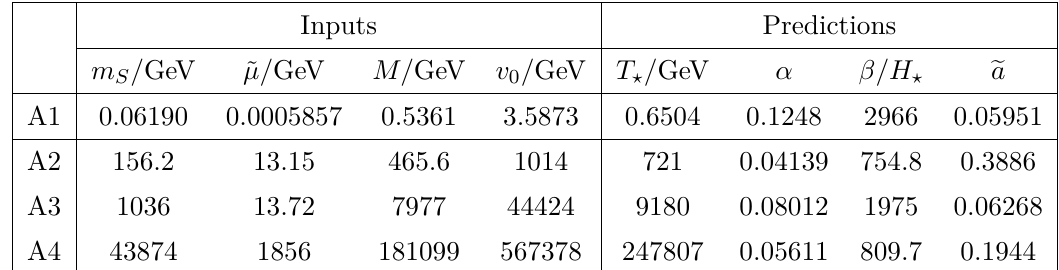
Table 1 . Values of the parameters corresponding to the four benchmark (starred) points in figure 2. Inputs